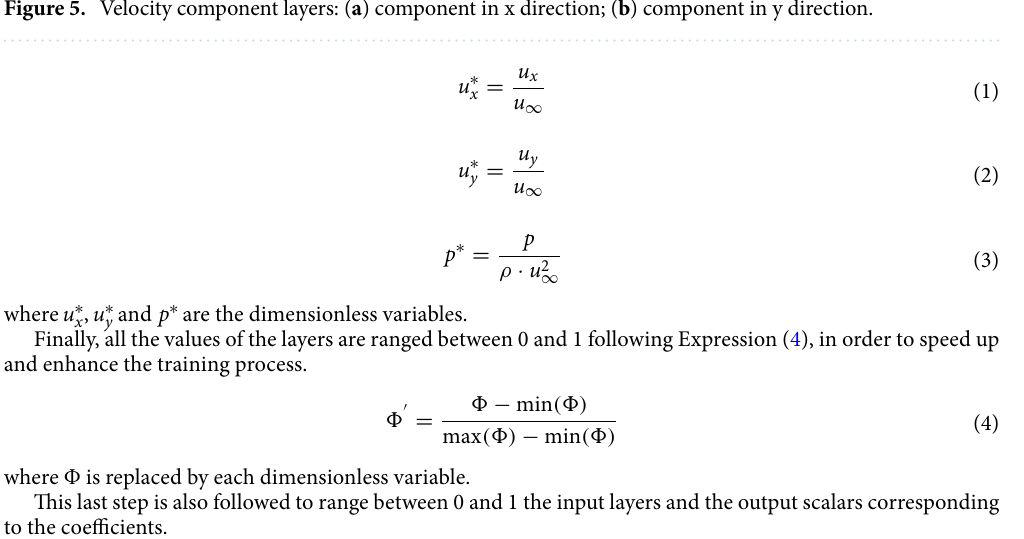
Figure 5. Velocity component layers: ( a ) component in x direction; ( b ) component in y